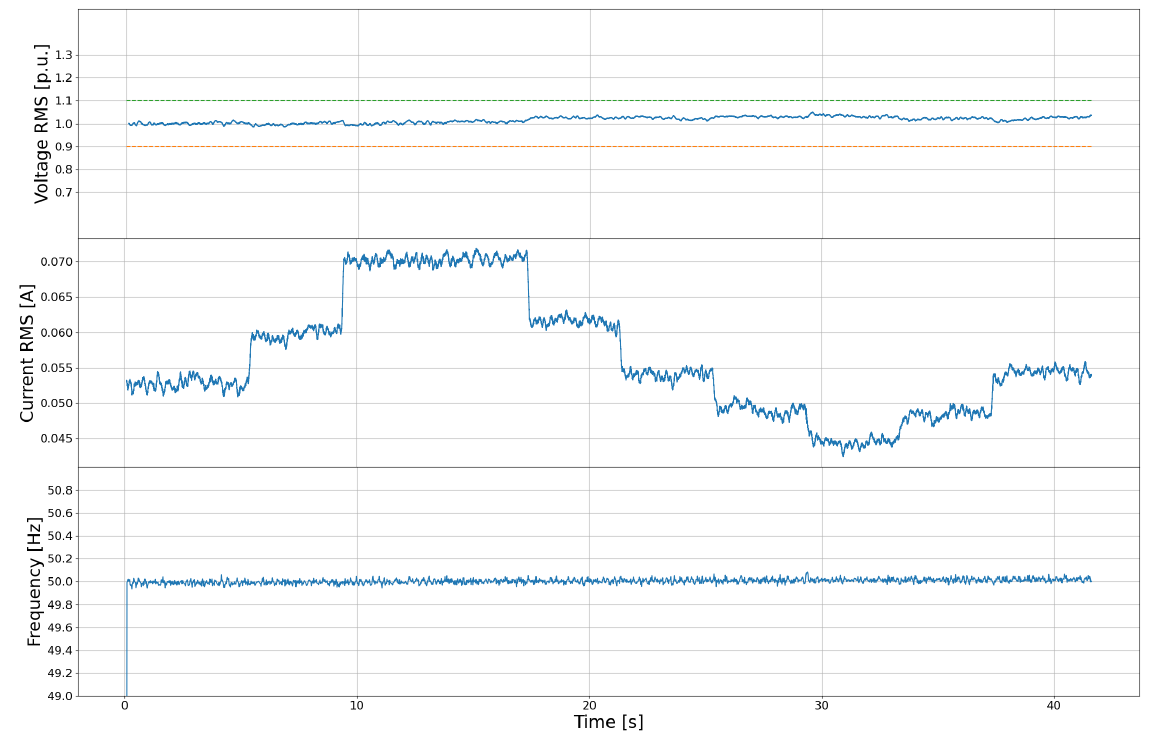
Figure 15. The change of current reference of controlled